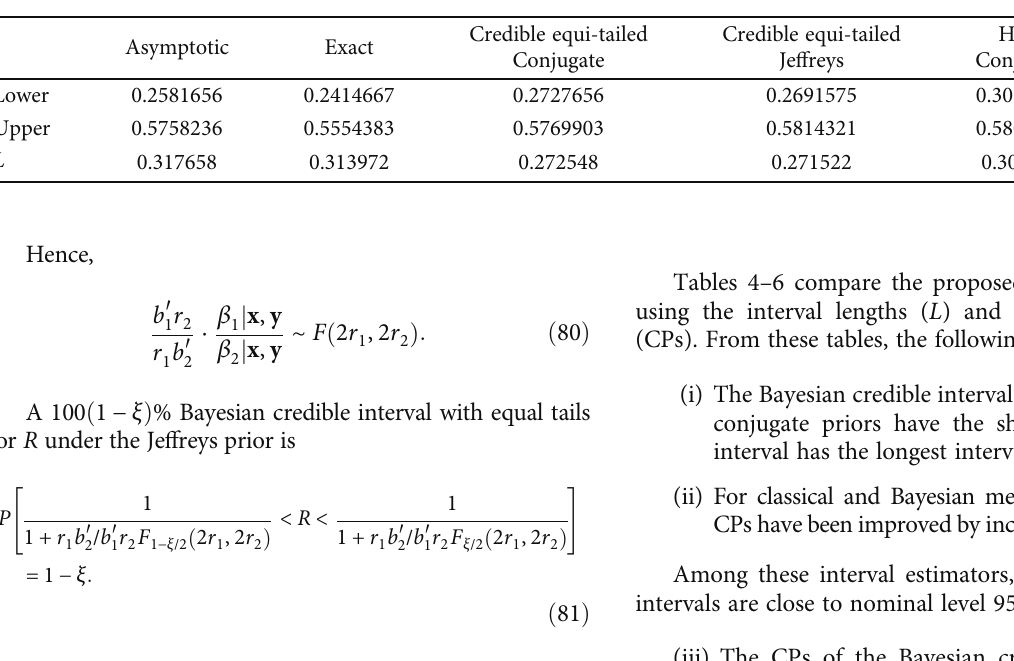
Table 9: Con fi dence intervals of R for real